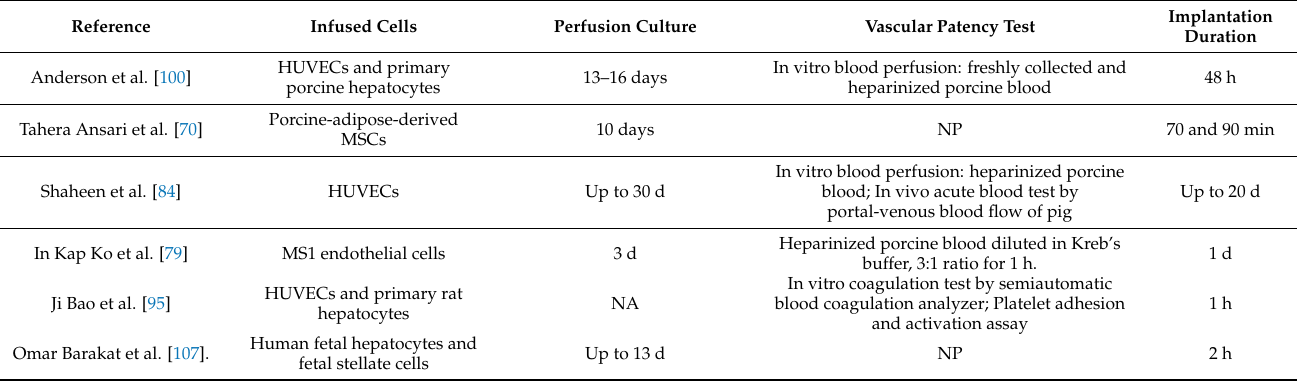
Table 2. Large animal models in transplantation